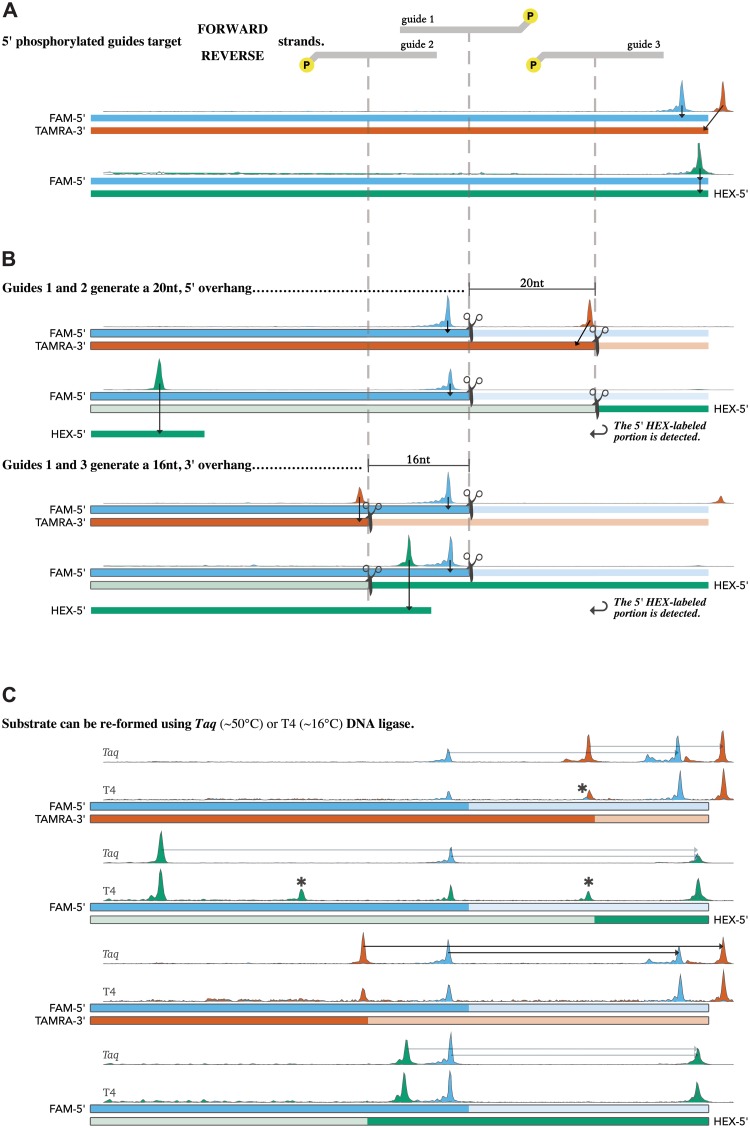
TtAgo as a programmable restriction endonuclease.Argonaute endonuclease reactions were performed in Taq DNA Ligase Reaction Buffer at 74 °C for 2 hr. Upon completion, the disappearance of substrate was monitored by CE, and the reactions were subsequently split and treated with either Taq or T4 DNA ligase supplemented with NAD+ or ATP, respectively. Full-length product was then re-annealed, ligated, and detected by CE—fluorescence peak data is shown above each substrate/product diagram. (A) The TAMRA dye is attached to the synthetic oligo via a modified thymidine; as such, the two targets differ in sequence by one base—a T in the 3′ terminal position of the TAMRA-labeled oligo becomes a G in the HEX-labeled oligo. This causes a slight difference in capillary migration time for the two FAM-labeled products. (B) Fluorophore hydrophobicity also affects product migration in the capillary; therefore, the peaks displayed correlate with the size as determined by a standard, which slightly differs from the actual length of the product. (C) T4 DNA ligase is able to generate a broader palate of ligation products than Taq DNA ligase due to increased functionality at lower temperatures and the ability to perform blunt end ligation. Peaks marked with (*) arise from ligation events involving excess 5′-phosphorylated DNA guide.